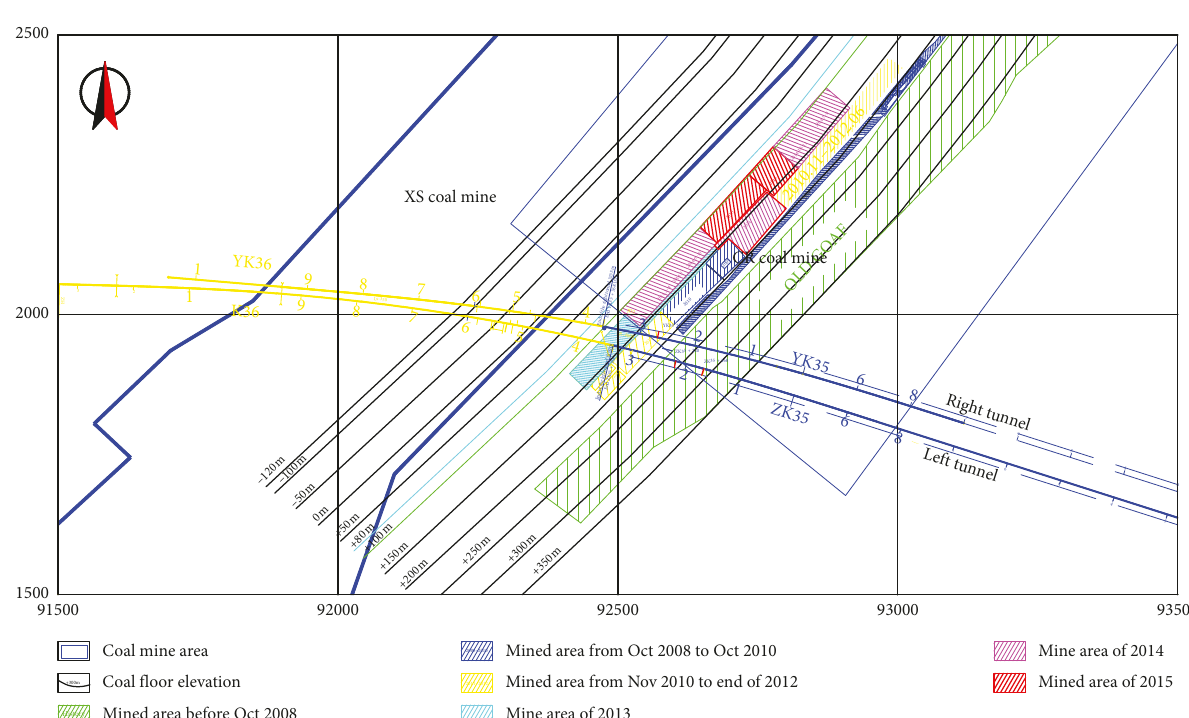
Figure 9: Coal mined area of K